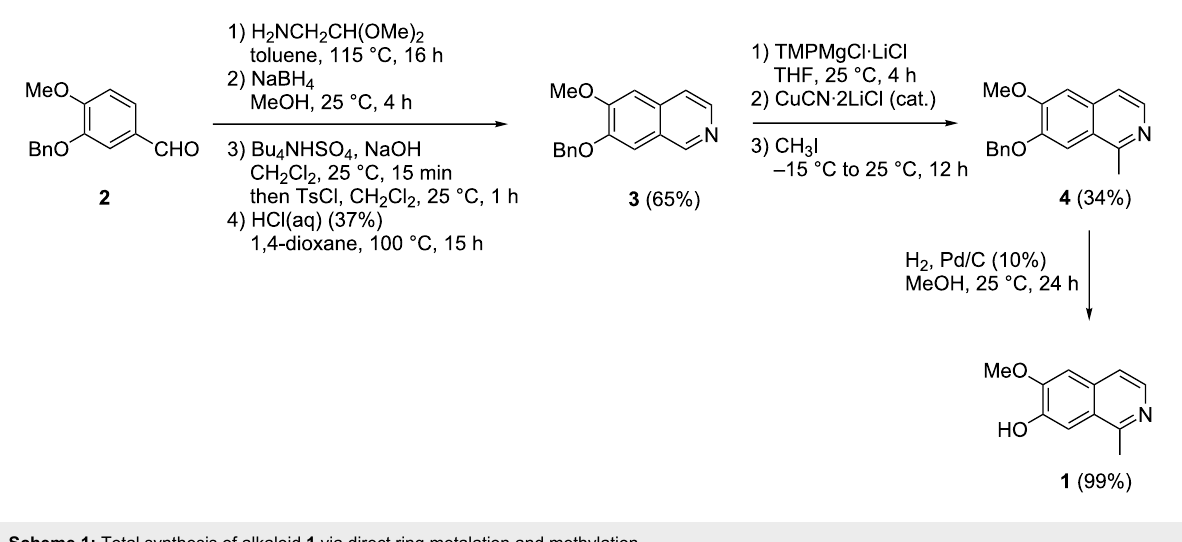
Scheme 1: Total synthesis of alkaloid 1 via direct ring metalation and methylation.